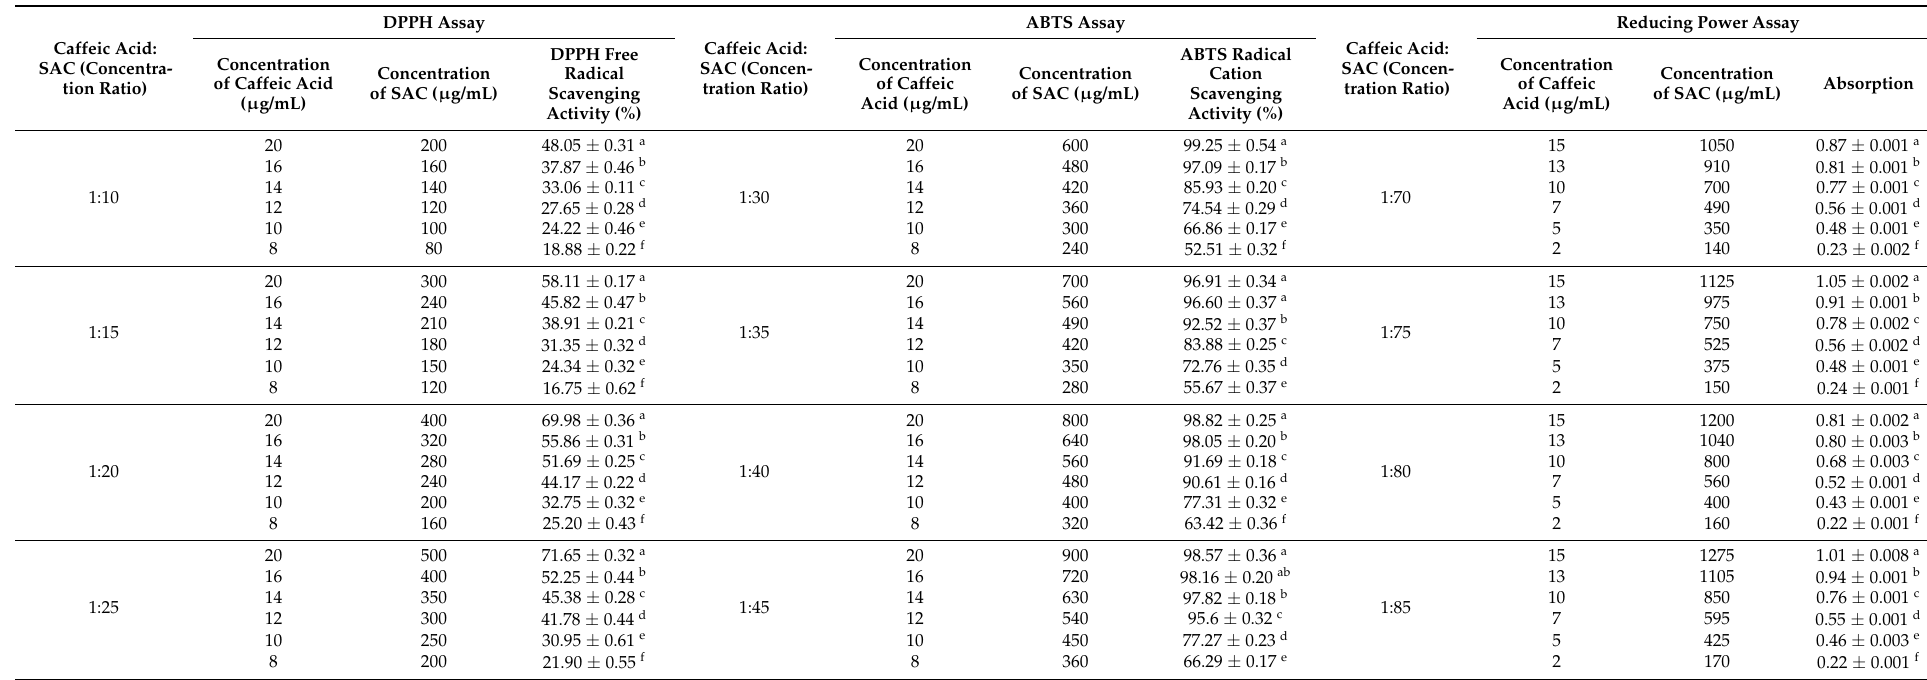
Table 3. Antioxidant activity for the mixture of caffeic acid and SAC determined by DPPH, ABTS, and reducing power